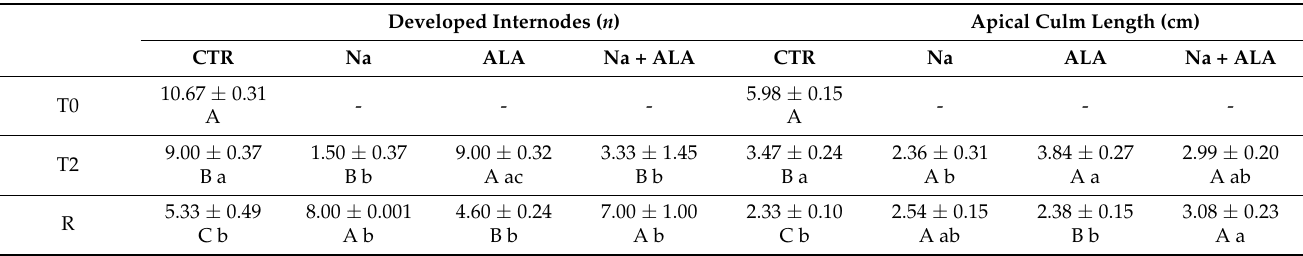
Apical leaves of control plants had a higher photosynthetic capacity and stomatal conductance (Figure 2; Table S2), as well as a higher effective quantum yield ( Φ PSII) (Table 2) than basal leaves. The chlorophyll concentration of apical control leaves remained lower than that of median leaves and only by the end of the experiment (58 days, R) was it equal to that of basal leaves (Table S3). After 14 days of treatment (T1), apical leaves of control plants had a lower IAA and a higher ABA concentration than basal leaves (Table 3), which resulted in a decreasing ABA/IAA ratio along the plant profile. A lower ALA concentration was found in the apical than in the basal leaves of control plants (Table 4).